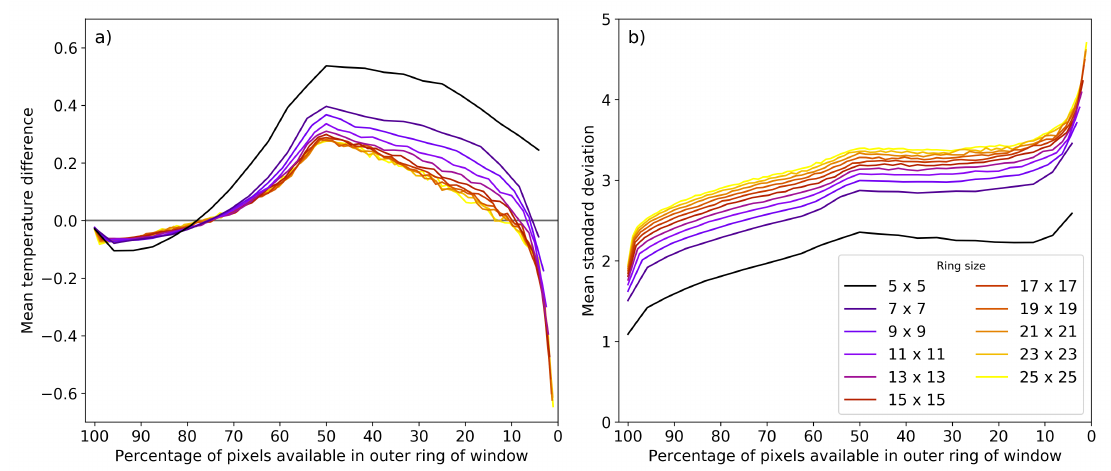
Figure 4. ( a ) Mean brightness temperature difference between contextual estimates and the central pixel for the ring of pixels at the edge of each window across the full disk for 0500 UTC B07 AHI-8 images; ( b ) Standard deviation of contextual estimates derived from each window edge by percentage of available pixels in the window